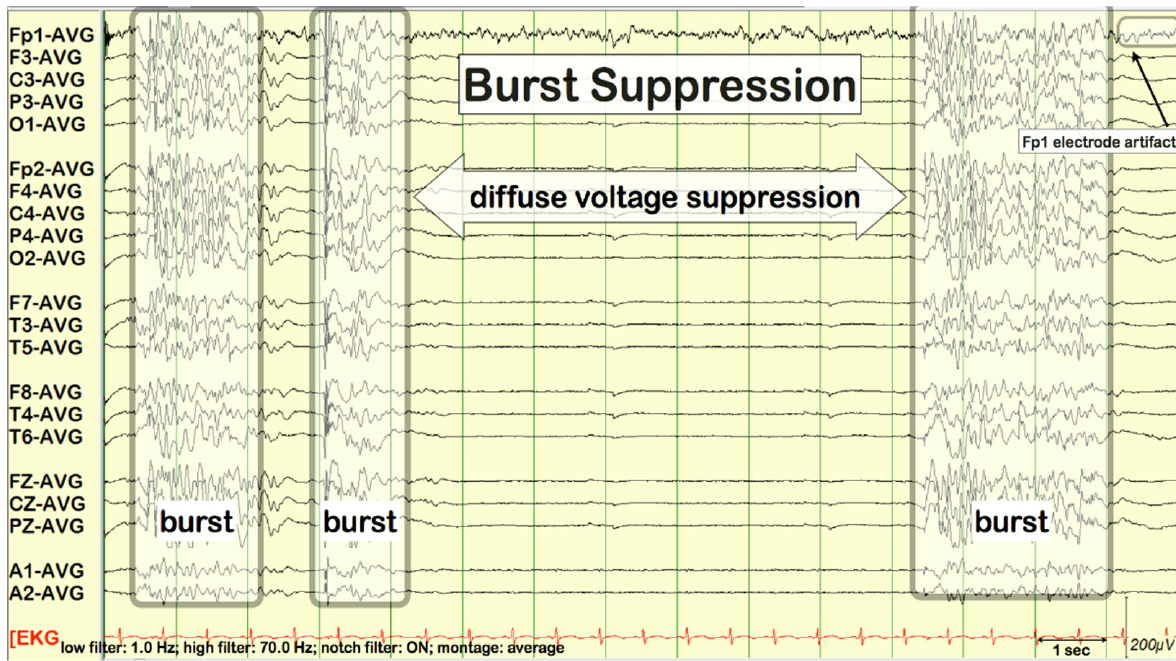
Figure 1. Burst-suppression pattern.